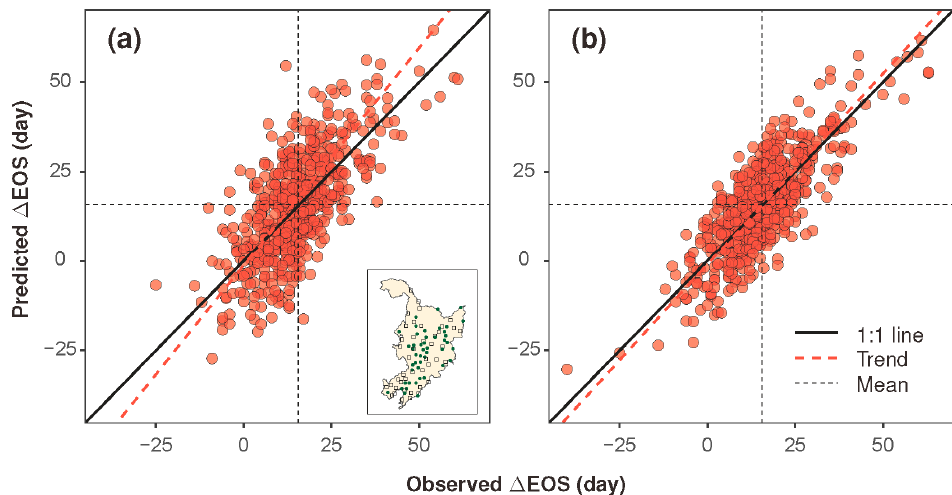
Figure 8. Comparison between the model-predicted versus station-characterized ∆ EOS using 50–50 ( a ) and leave-one-out cross-validation methods ( b ). The inset figure in ( a ) shows the spatial setting of the stations used in model training (solid dots, 50%) and model validation (hollow squares, 50%). The regression equations of the trend lines are 𝑦 = −1.23 + 1.22𝑥 ( a ) and 𝑦 = −0.99 + 1.07𝑥 ( b ).